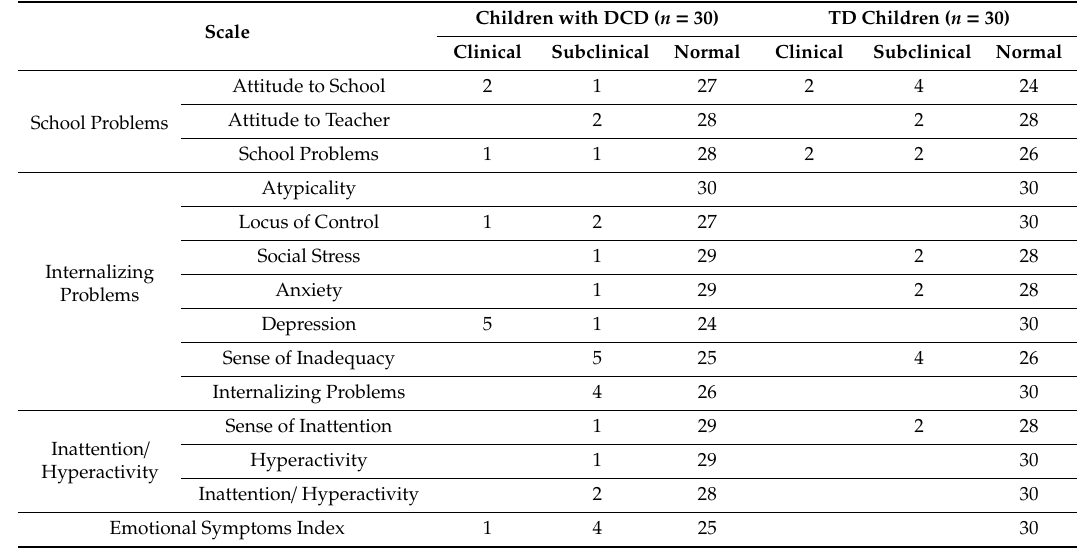
Table 3. Clinical, subclinical, and normal level distribution of participants in emotional